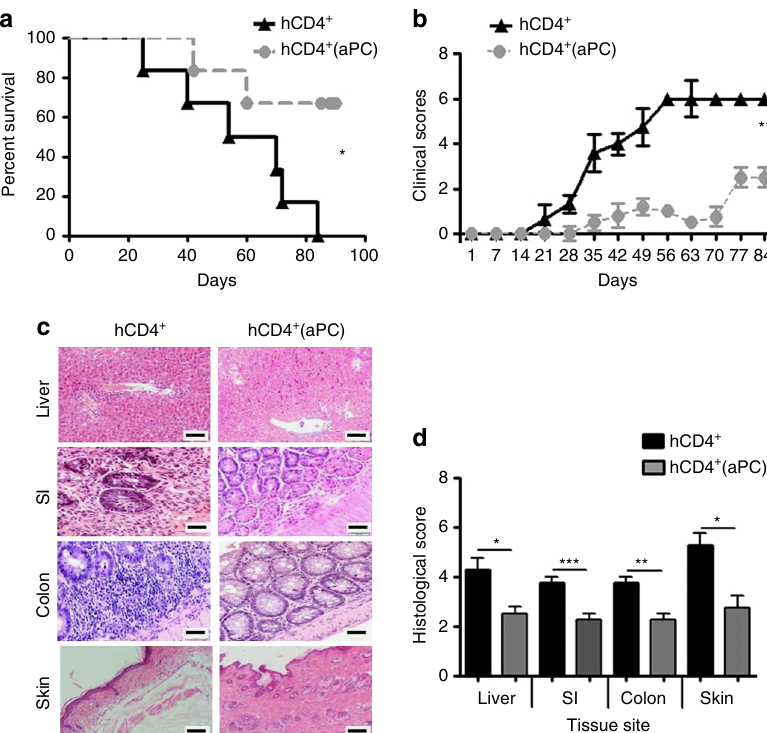
Fig. 9 aPC mitigates human CD4 + T-cell mediated GvHD. a , b Recipient NSG-Ab DR4 mice were irradiated with 2 Gy and transplanted 4 h later with 4 × 10 6 of human CD4 + T-cells (HLA-DR4 − ) without (hCD4 + ) or with (hCD4 + (aPC)) aPC-preincubation. Survival ( a Kaplan – Meier curve) and physical parameters ( b clinical score) are shown; pooled data from three independent experiments each with two recipients. c , d Photomicrographs depicting typical morphology in liver, small intestine ( SI ), colon, and skin; haematoxylin and eosin stained section ( c ), size bar 50 µ m and bar graph summarizing histological disease scores; mean value ± SEM ( fi ve mice per group, d ). *P < 0.05, ** P < 0.01; *** P < 0.001 ( a log-rank test; b ANOVA; d t